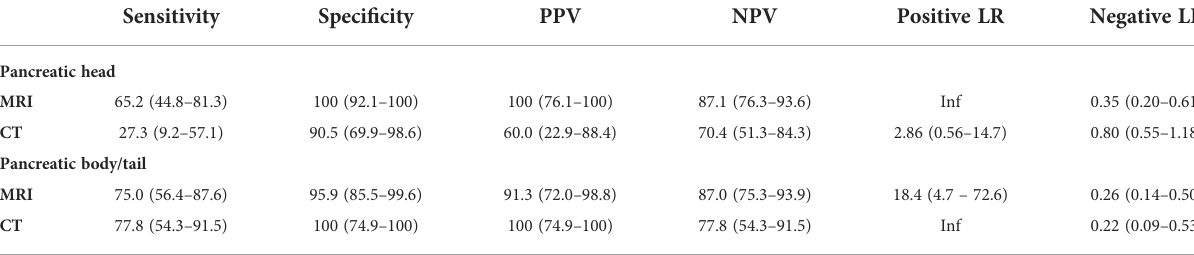
TABLE 4 Diagnostic accuracy measures of MRI and CT as fi rst imaging study in 2010 – 2017.